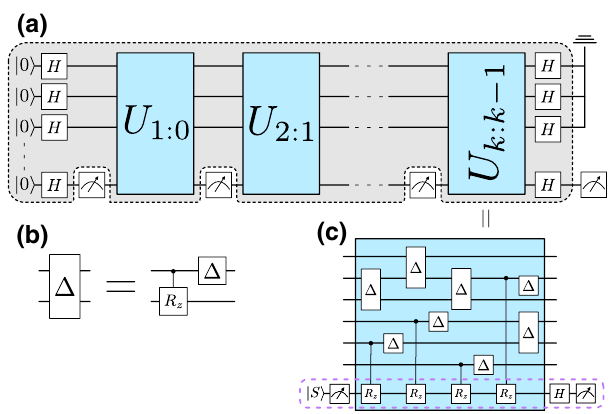
FIG. 6. (a) The circuit construction of OpenDQP – ( IQP ) . (b) The decomposition of a two-qubit Z -diagonal gate ( (cid:15) ) into a controlled- R z and single-qubit Z -diagonal gate. (c) Each gate acting between an environment qubit and the system can be decomposed according to the description in (b). The net result is a series of gates acting between environment qubits and a series of R z gates acting on the system conditioned on environment qubits. The resulting operations acting on the system are outlined with the purple traced